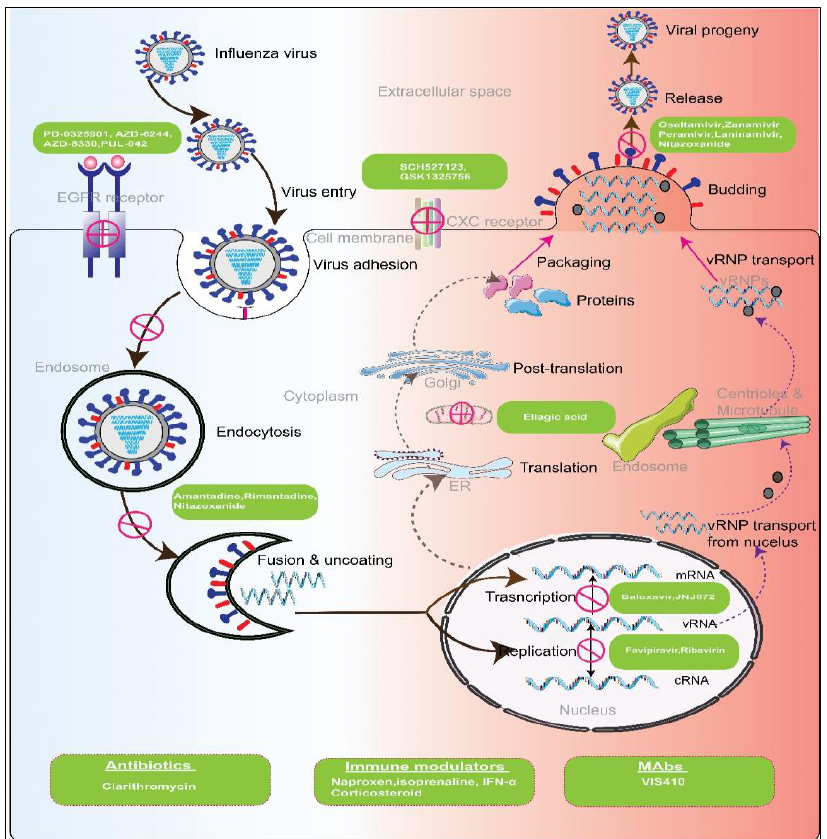
Figure 2. Potential targets of antiviral and other immunomodulators for different factors of pathogen and host. Influenza virus enters the cytoplasm by receptor-mediated endocytosis by recognition of sialic acid receptors. The low pH in the endosome induces the release of RNA, a therapeutic target of several antivirals. Transcription and replication from RNA occur in the nucleus, and both steps are inhibited by antivirals targeting the PA endonuclease and RdRps. Packaging and release of the virion occur at the cell membrane, and neuraminidase inhibitors block this step. Immunomodulators and other agents target host factors and stimulate the immune system against viral infection.